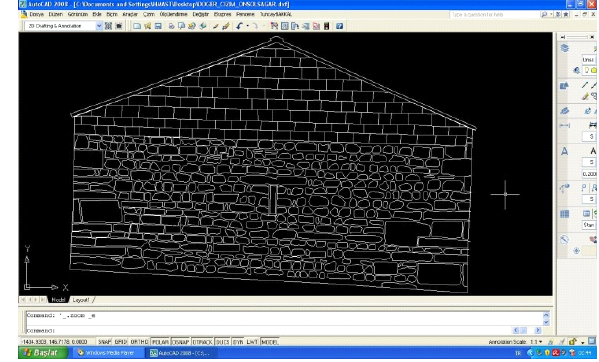
Figure 8. Surface of Caravansary in AutoCAD software